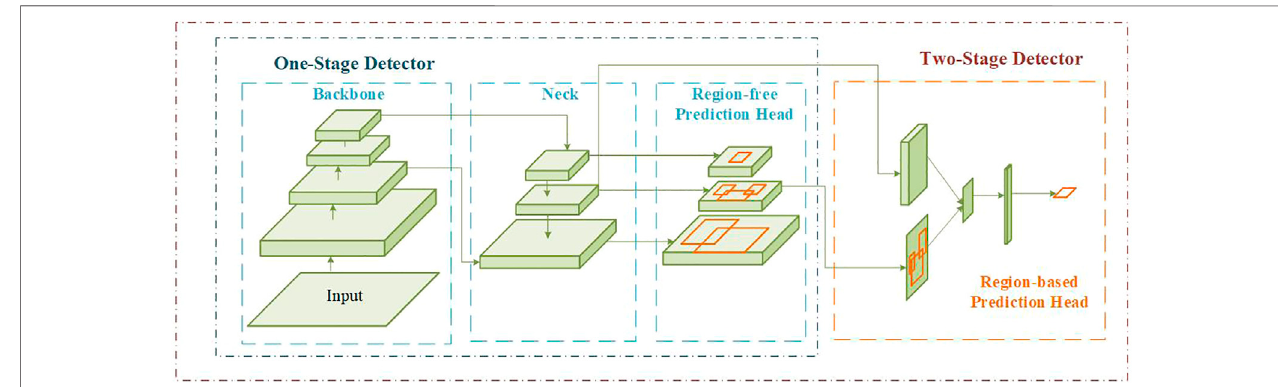
FIGURE 1 | Comparison of the one-stage and two-stage object detection